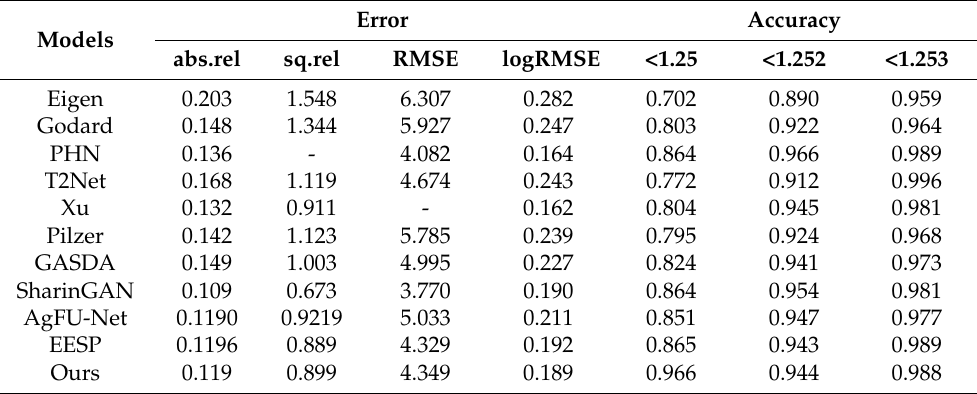
Table 1. Comparison between our method and other methods on the KITTI dataset.